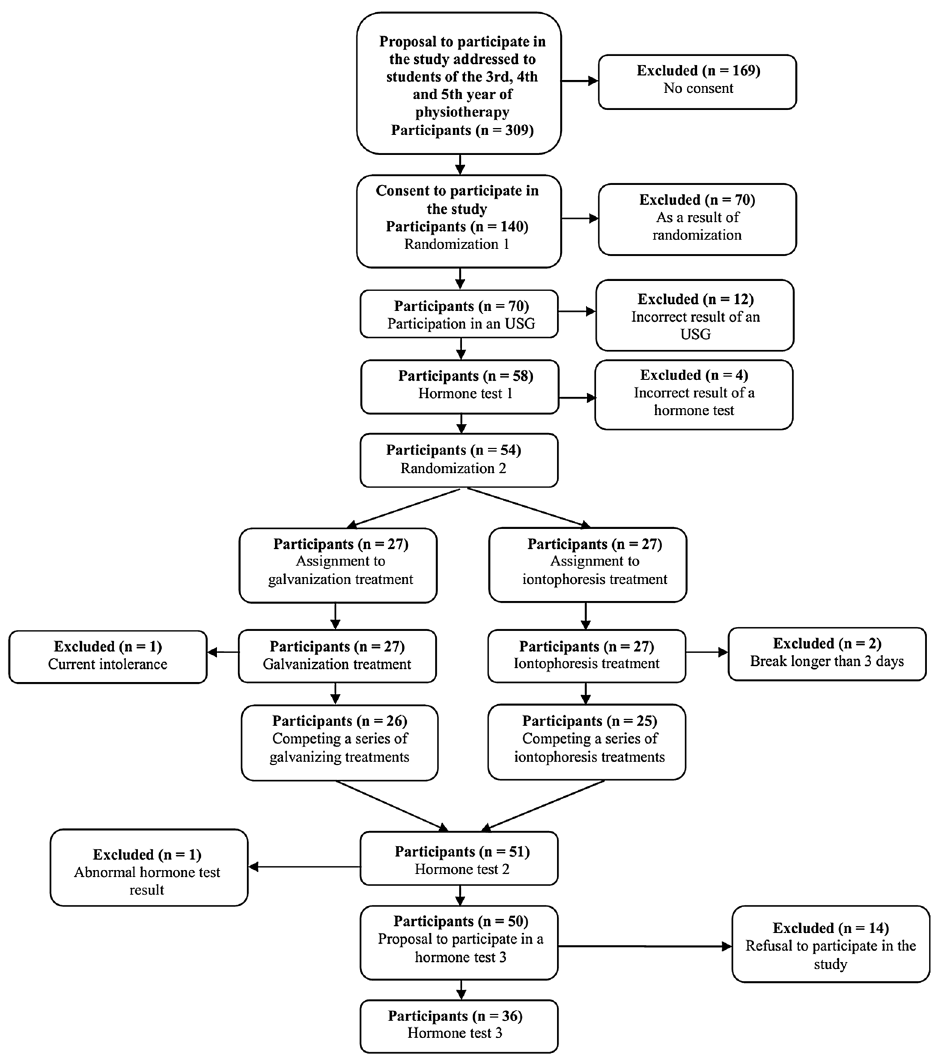
Figure 1. Design and flow of participants in the